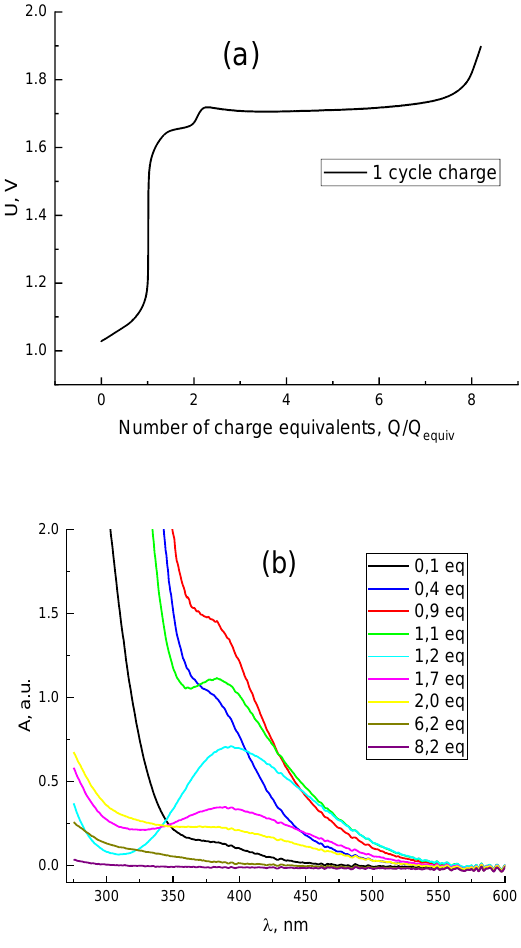
Figure 4. Charging curve of H 2 -BrO 3 − flow battery ( a ) and the evolution of the corresponding spectrum of the catholyte ( b ) in the course of galvanostatic polarization by 0.075 A/cm 2 , starting composition of the positive-electrode solution: 0.3 M HBr + 3 M H 2 SO 4 , solution flow rate: 30 mL/min, exit of the negative electrode is open to the atmosphere.